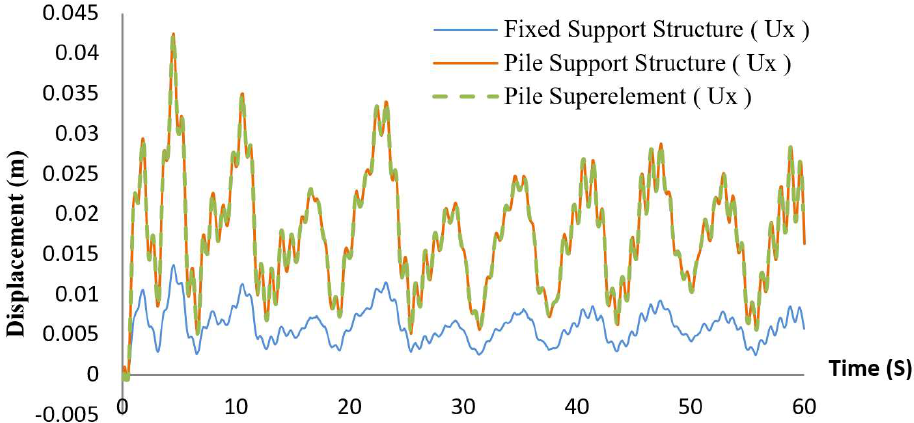
Figure 16. A comparison of the displacement on the fixed support structure, piled-support structure and pile superelement models in the x-direction.